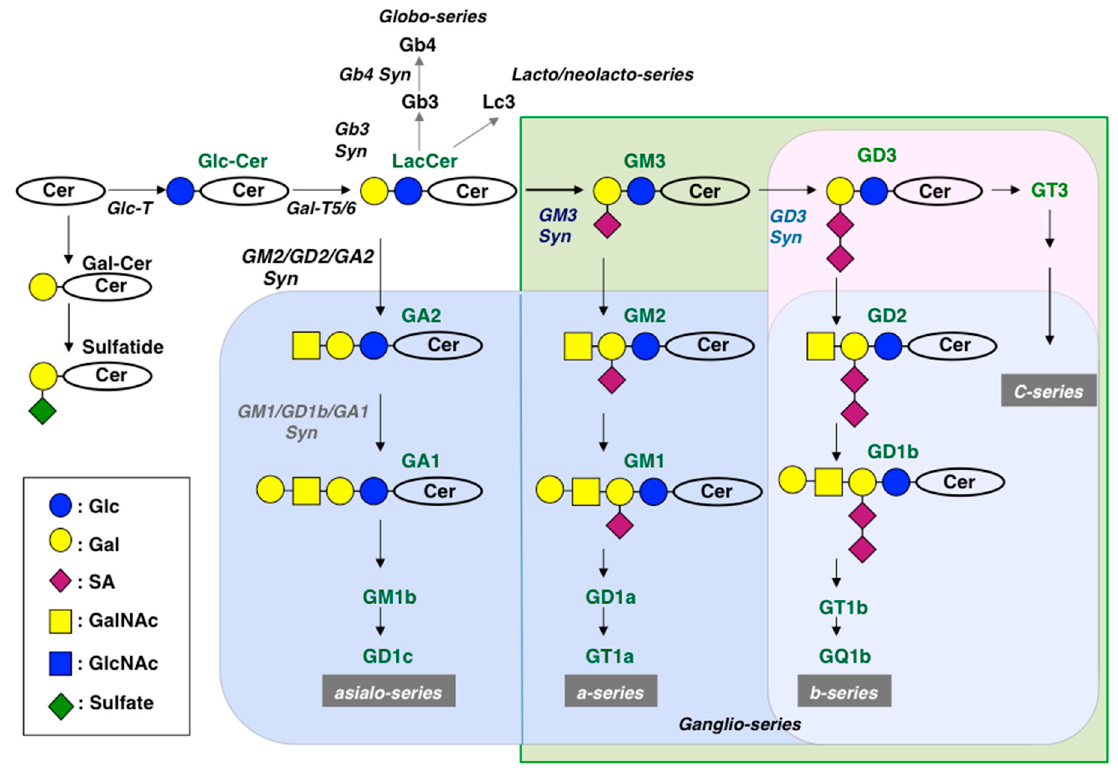
Figure 2. Main pathway of ganglioside synthesis. Glycosyltransferases catalyzing individual steps are shown by italics, and deleted structures in KO mice are shown by different colored squares. Structures on the line of ganglioside synthesis are presented in green letters.